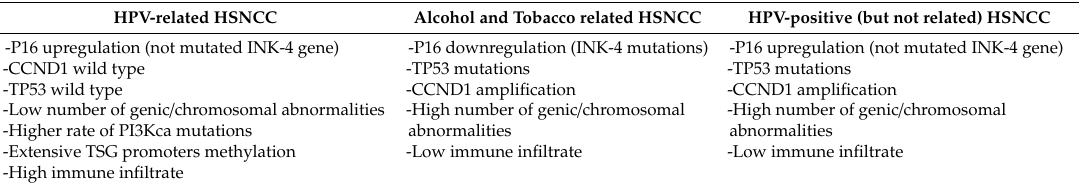
Table 1. The picture describes the main genetic features characterizing the virus-related, the mutagens-related HSNCC and the HPV positive but not related